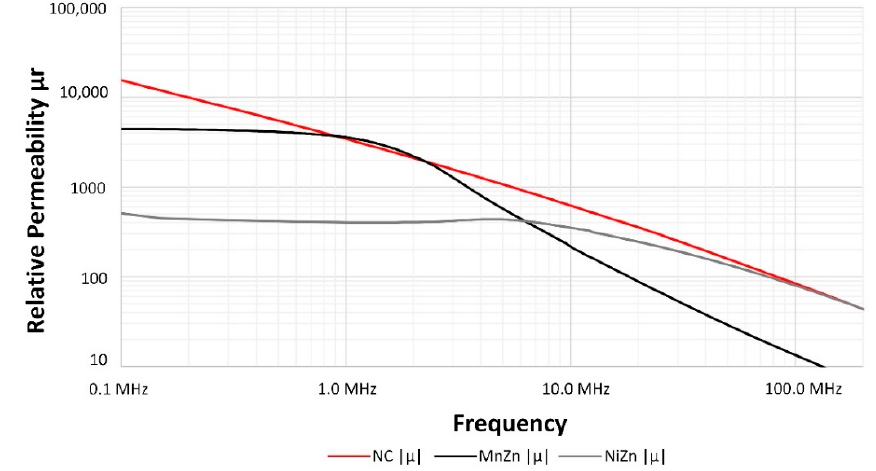
Figure 2. Relative Permeability of nanocrystalline (NC) compared with MnZn and NiZn sleeve ferrite cores compositions.